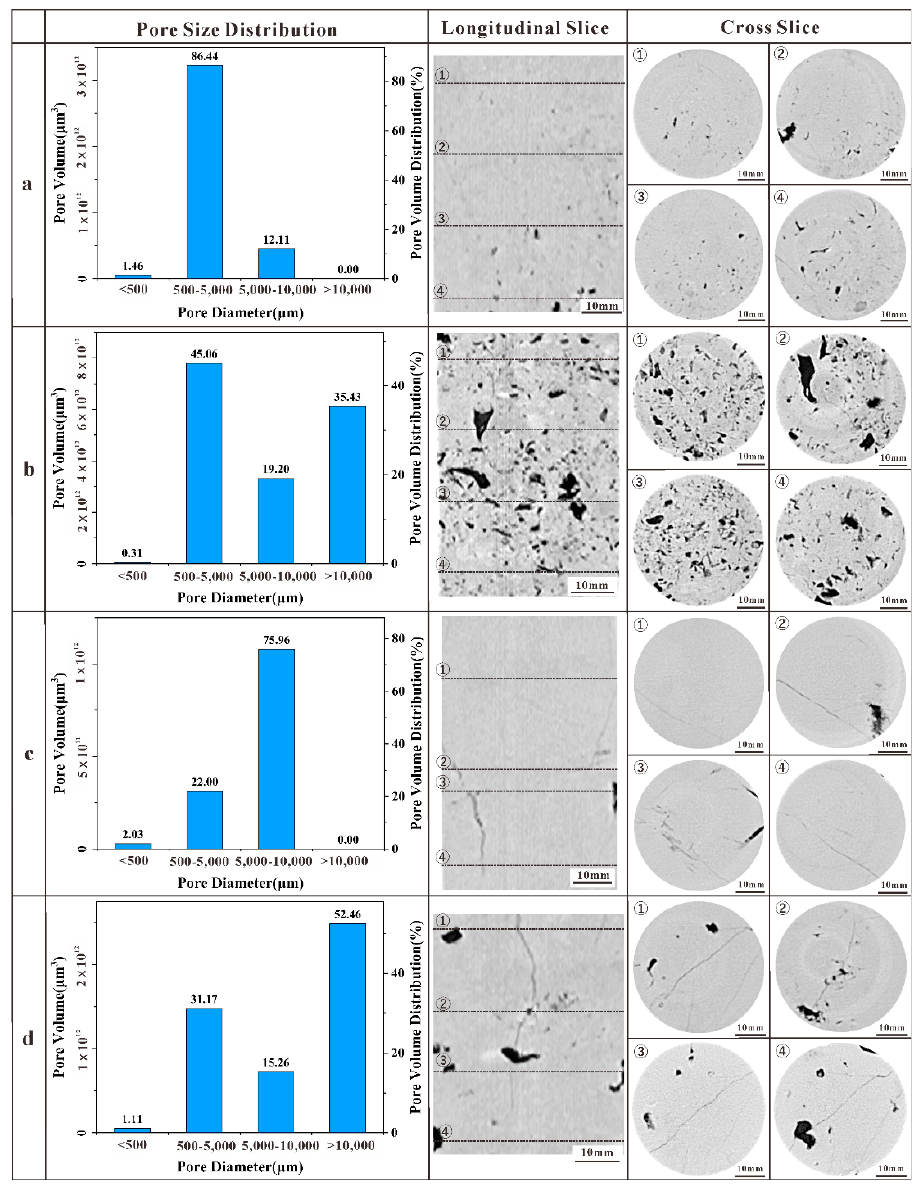
Figure 8. Examples of carbonate types of pore system classification from CT images. ( a ) Type-I, sample SHY026, mainly developed small vugs with a diameter of 1–2 mm, locally developed, and large vugs with a diameter of 7–8 mm. ( b ) Type-II, sample SHY002, flat vugs with a diameter of 2–6 mm. ( c ) Type-III, sample SHY006, cracks. ( d ) Type-IV, sample SHY009, a multitude of flat vugs with a diameter of 3–4